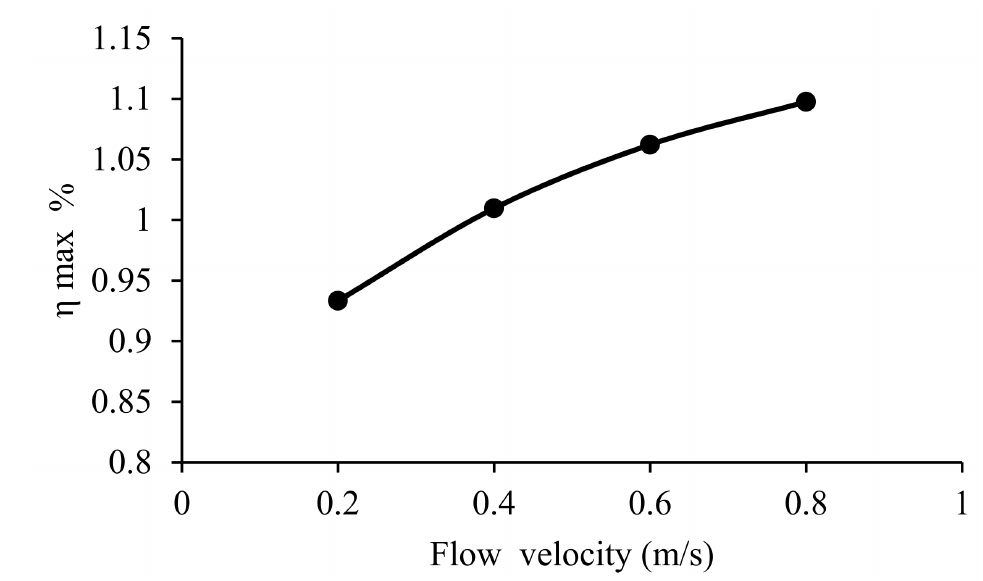
Figure 13. The relation between flow velocity and TEG